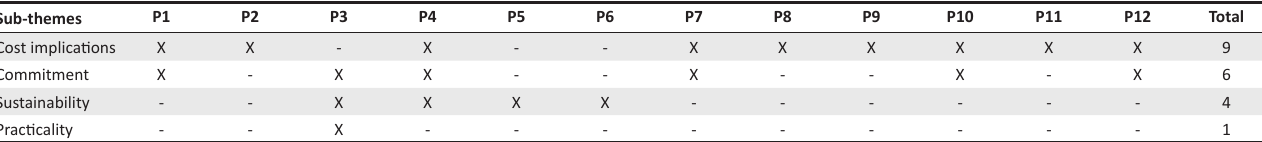
TABLE 3: Overview of participants’